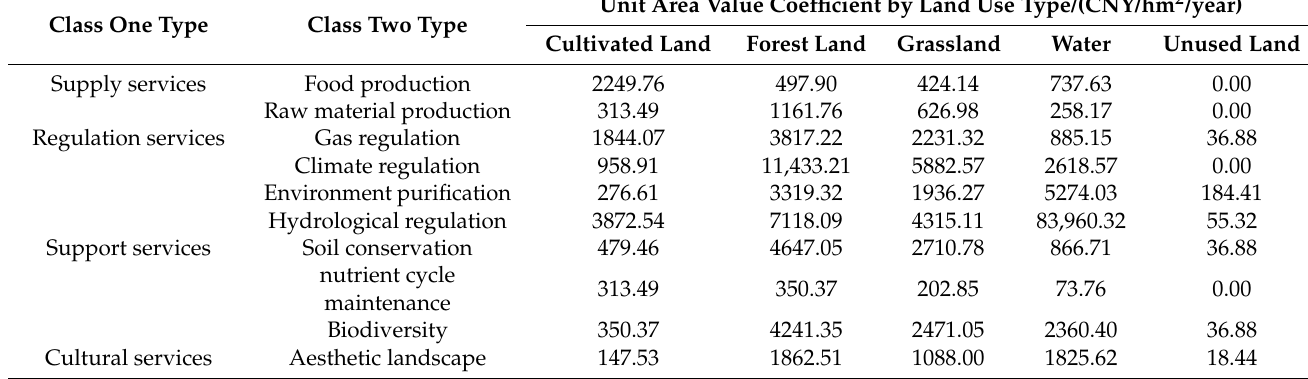
Table 1. The ESV coefficients per unit area in the Nanjing metropolitan